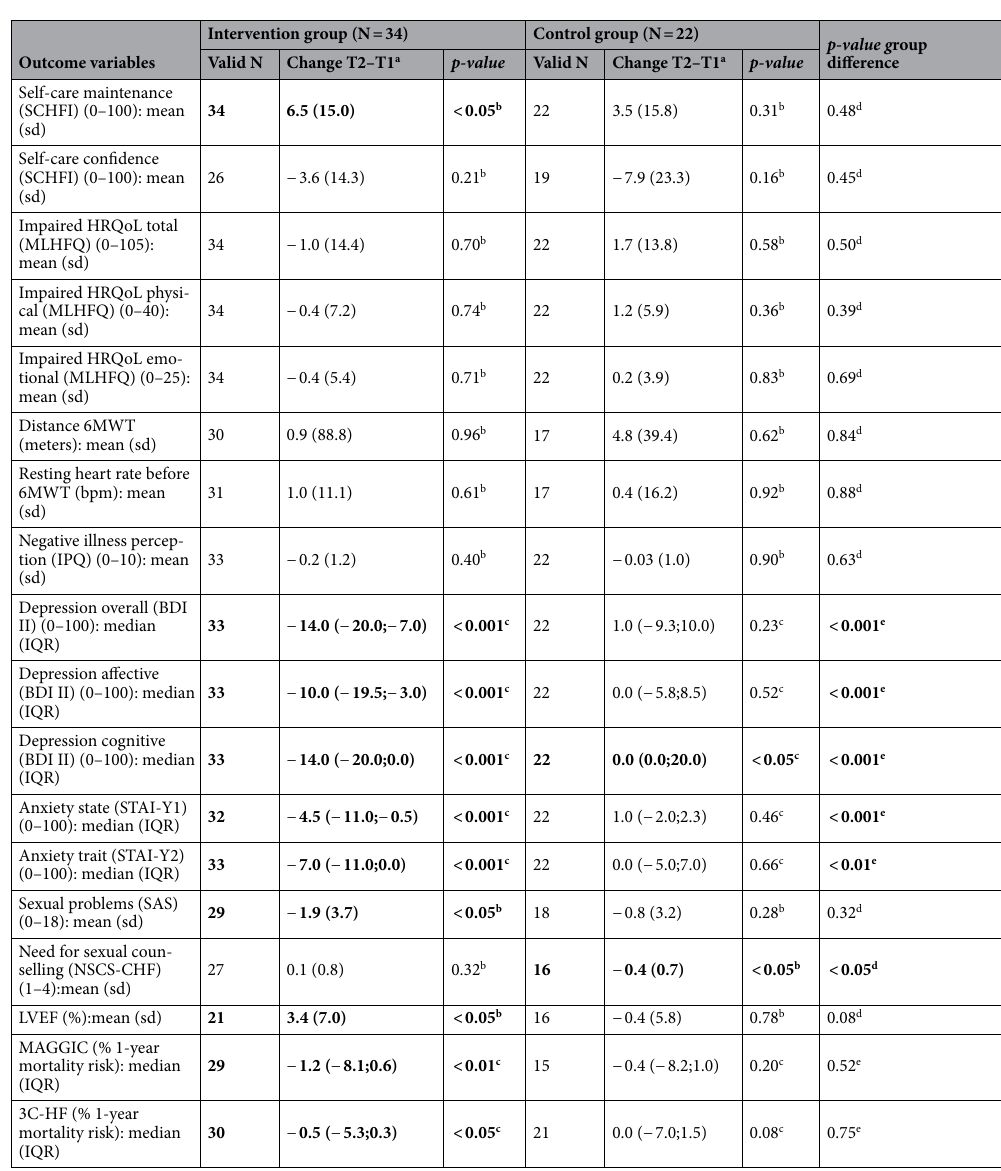
Table 2. Change in outcome variables from T1 to T2 in intervention and control group. SCHFI, Self-Care of Heart Failure Index; HRQoL, health-related quality of life; MLHFQ, Minnesota Living with Heart Failure Questionnaire; 6MWT, 6-min walking test; bpm, beats per minute; IQR, inter-quartile range; LVEF, left ventricular ejection fraction. Significant results are shown in bold. a Positive value indicates increase from T1 to T2, while negative value indicates decrease from T1 to T2. b Result from paired-samples Student’s t-test. c Result from Wilcoxon signed-rank test. d Result from independent samples Student’s t-test. e Result from Mann Whitney U